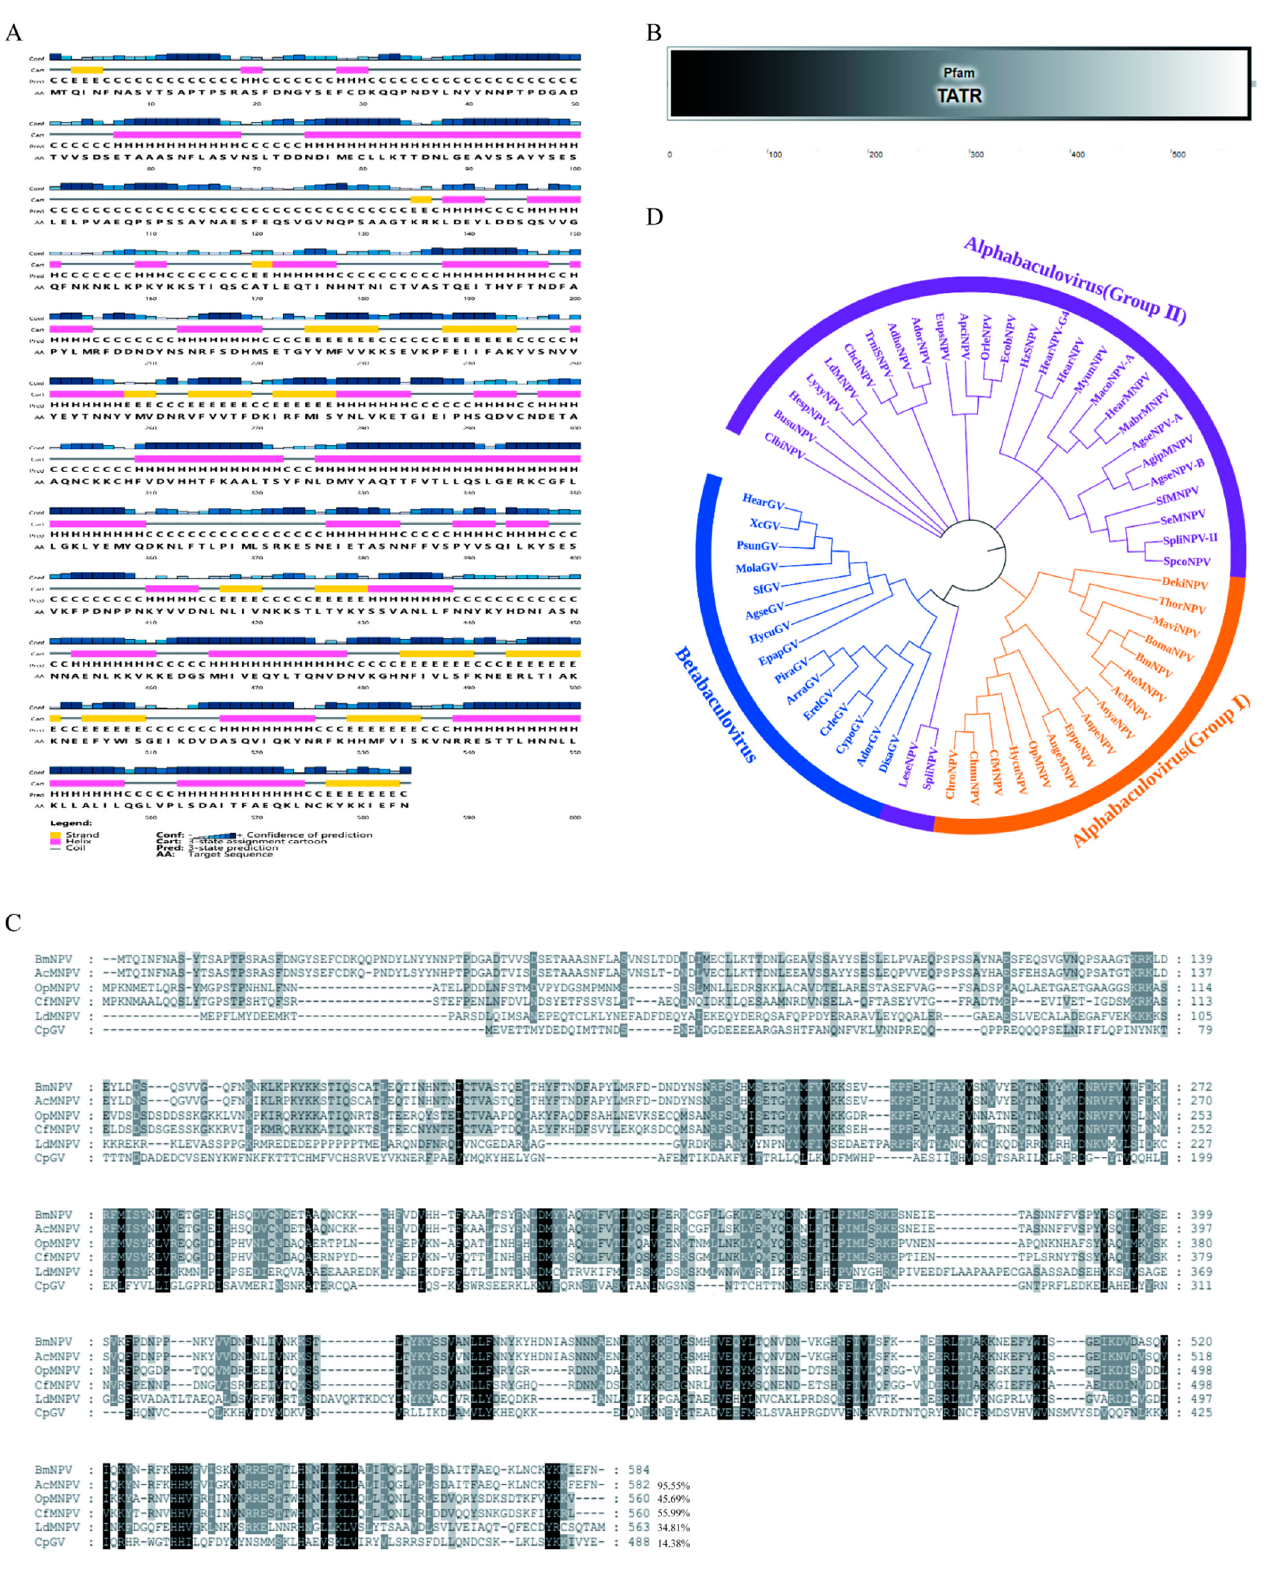
Figure 1. Sequence characterization of BmNPV IE1. ( A ) Secondary structure of BmNPV IE1 predicted by PSIPRED software (http://bioinf.cs.ucl.ac.uk/psipred/, accessed on 12 April 2021). The first row indicates the confidence of prediction; the second row indicates the cartoon pattern of predic- tion, yellow rectangle indicates strand structure, pink rectangle indicates helix structure, gray